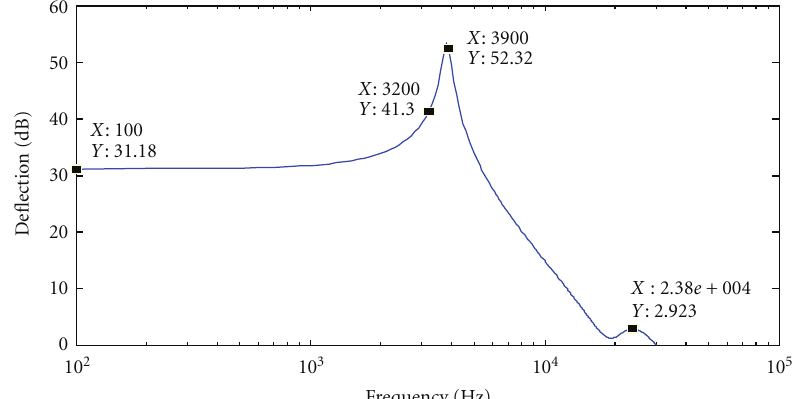
Figure 8: Harmonic response total maximum deflection Decibels (re 1 . 3 × 10 − 6 ) for a 1000 Pa pressure acting on one surface of the blade.